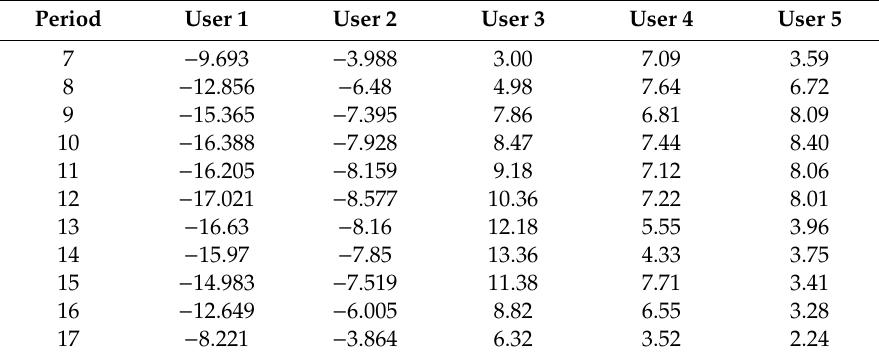
Table 13. User transaction volume in microgrid (kW ·